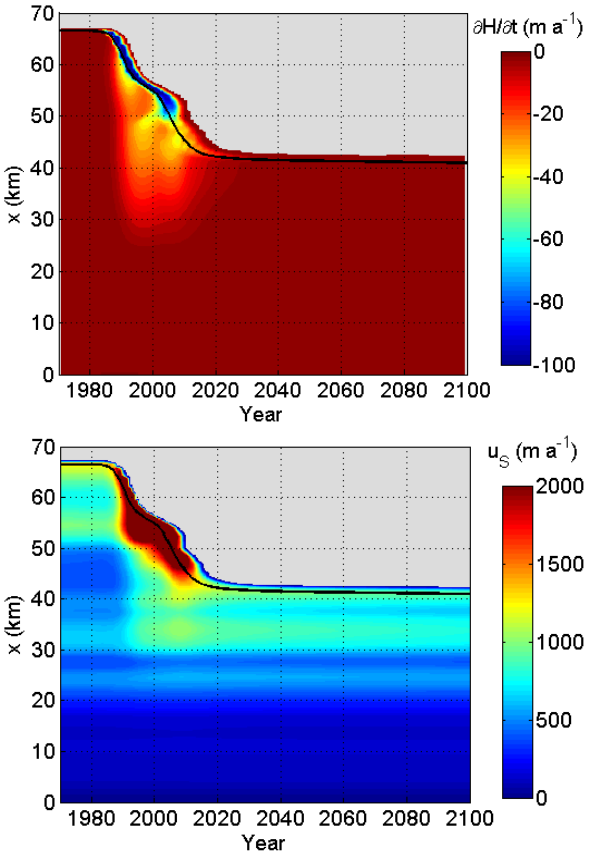
Fig. 12. Modelled time-space evolution of ensemble mean rate of change of ice thickness ( ∂H / ∂t ) and surface ice velocity ( u s ) along the Columbia Glacier main flowline ( x) between 1970 and 2100. Colorbars saturate at − 100ma − 1 and 2000ma − 1 , respectively. The black line denotes the ensemble mean terminus position over the period.